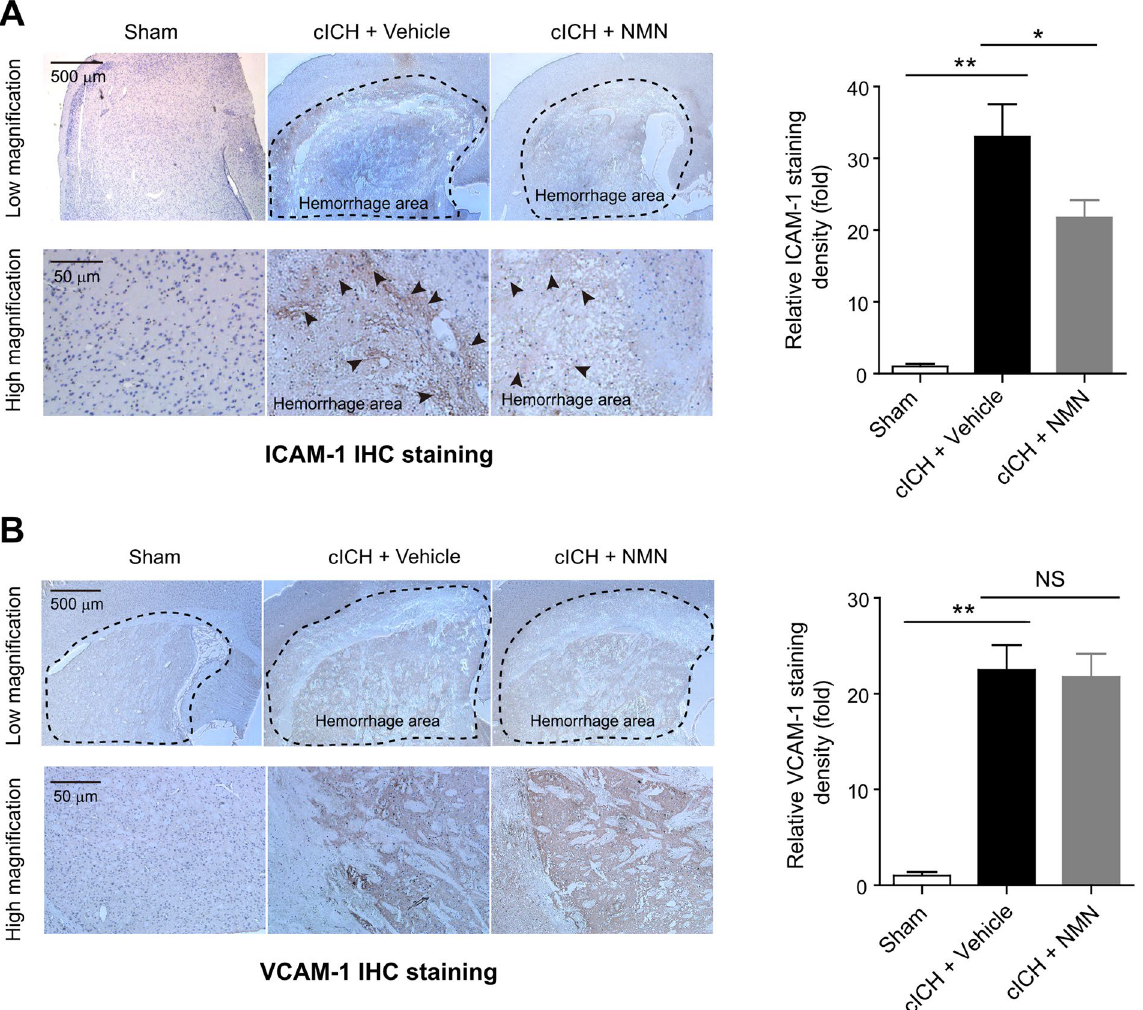
Figure 5. Effects of NMN on the expression of ICAM-1 and VCAM-1 in mouse cICH model. ( A ) Representative immunohistochemistry staining images and quantitative analysis of ICAM-1 at 24 hours post cICH; ** P < 0.01 cICH + Vehicle vs Sham, * P < 0.05 cICH + NMN vs Cich + Vehicle, n = 5 per group. ( B ) Representative immunohistochemistry staining images and quantitative analysis of VCAM-1 at 24 hours post cICH; ** P < 0.01 cICH + Vehicle vs Sham, * P < 0.05 cICH + NMN vs cICH + Vehicle, n = 5 per group. IHC,